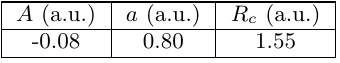
Table 1. Values for the pseudopotential parameters. The same values are used for the two temperatures